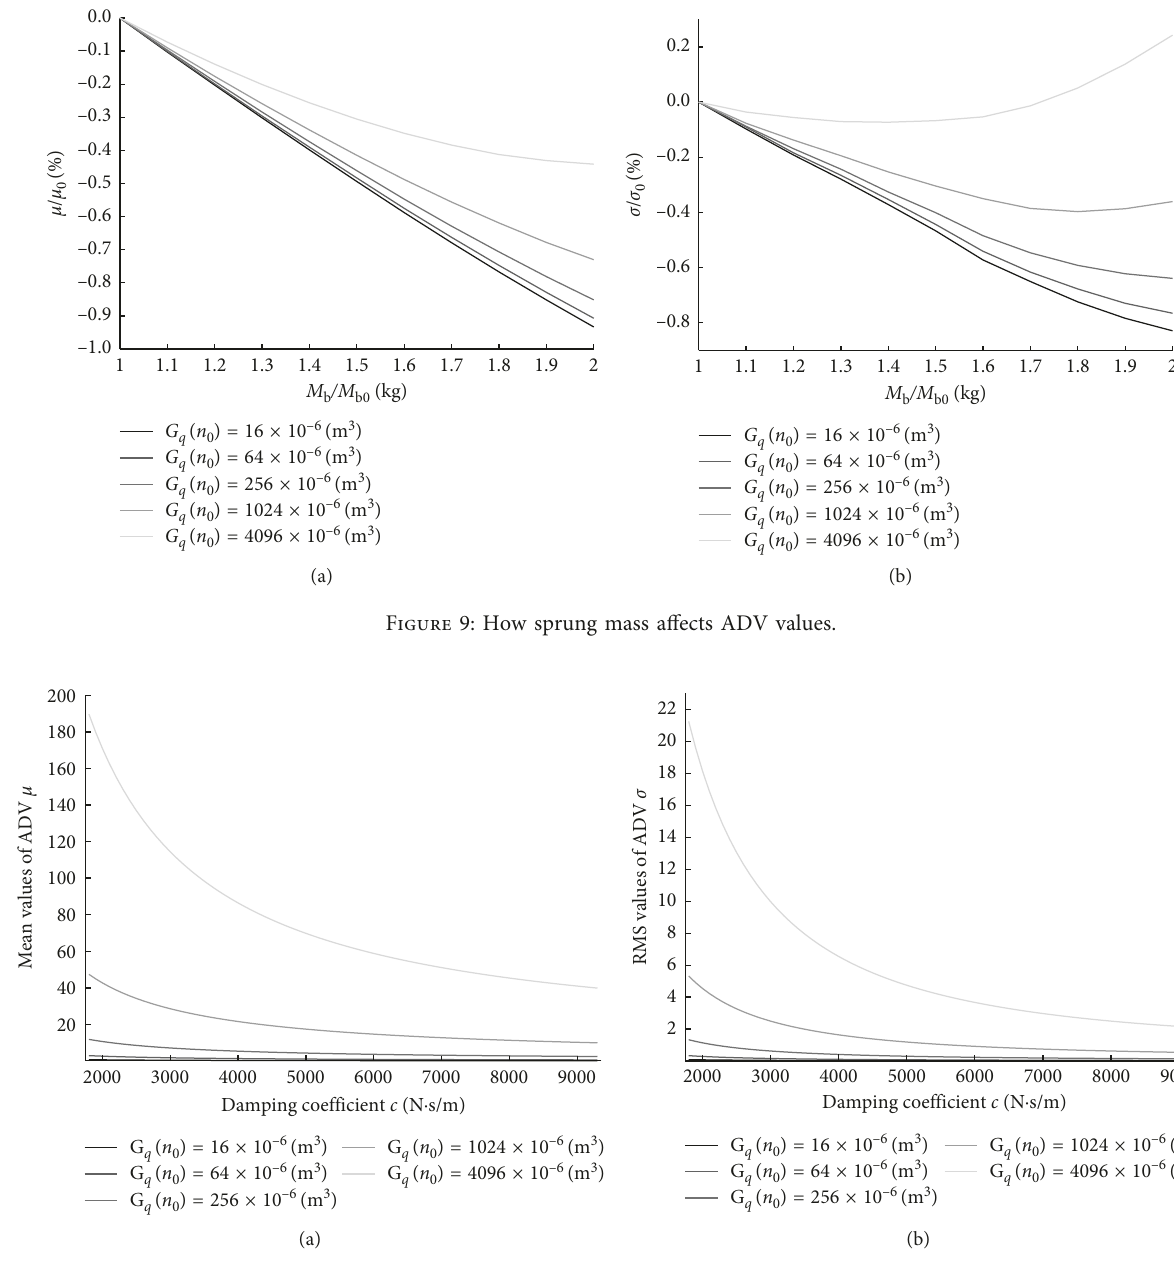
Figure 10: How damping coefficient affects ADV values.